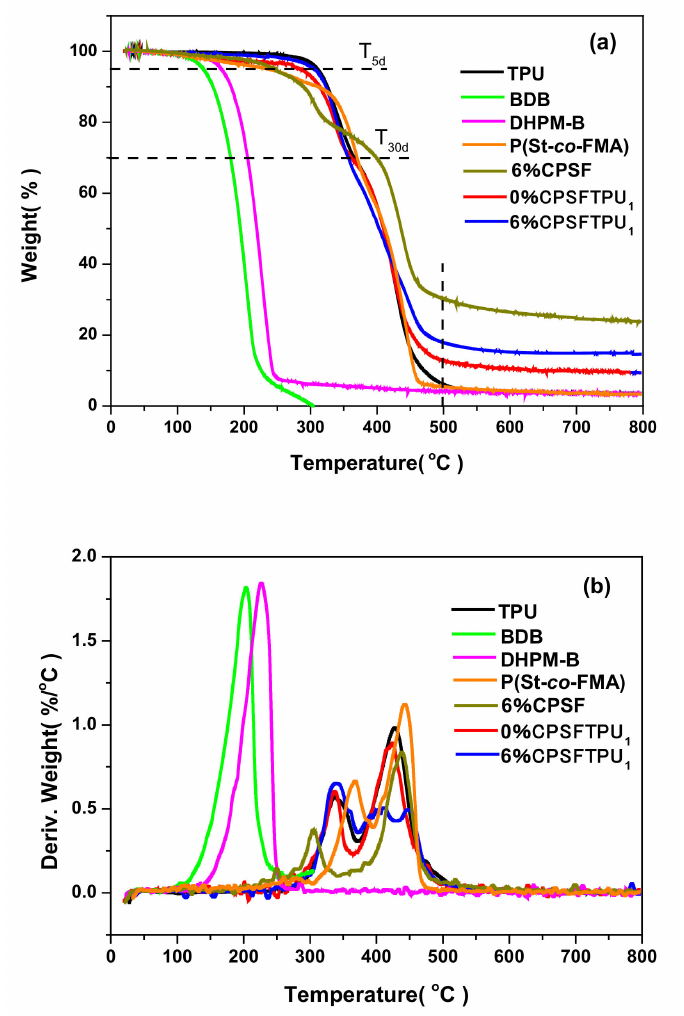
Figure 10. TGA ( a ) and DTG ( b ) curves of TPU, BDB, DHPM-B, P(St- co -FMA), 0%CPSFTPU 1 and 6%CPSFTPU 1 . Table 4. Thermal stability factors of TUP, BDB, DHPM-B, P(St- co -FMA), 0%CPSFTPU 1